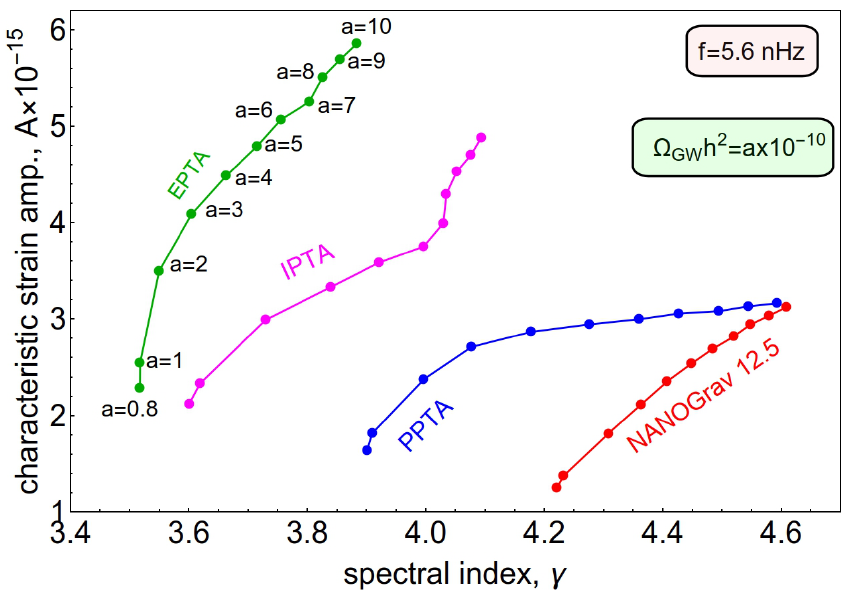
Figure 3 . Best fit values of the parameters ( A, γ ) for the various PTAs with a fixed frequency, f = 5 . 6 nHz. Good fits (i.e., P χ 2 < 2 ) are obtained for a ∼ [1 , 6] . See text for